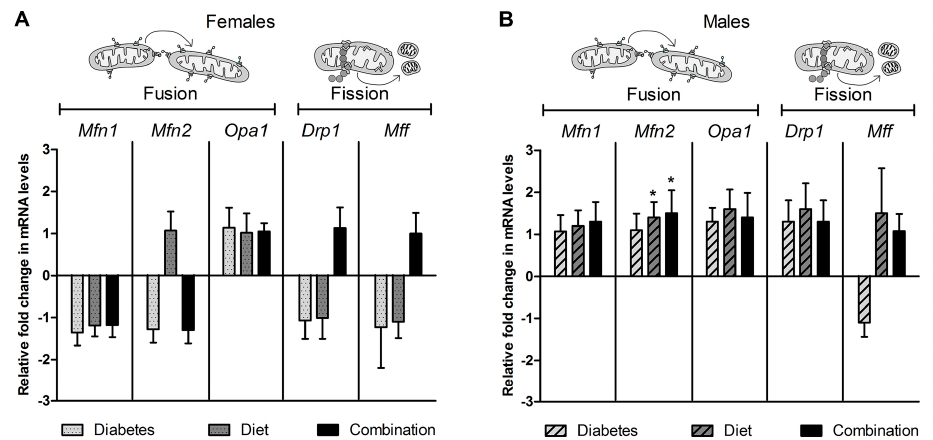
Figure 4. Cardiac expression of dynamism regulating genes cannot explain impaired dynamism in NRCM exposed to maternal diabetes, high-fat diet, or the combination of both. Whole heart mRNA was isolated from newborn offspring and relative expression of mitofusin 1 ( Mfn1 ), mitofusin 2 ( Mfn2 ), optic atrophy 1 ( Opa1 ), dynamin related protein 1 ( Drp1 ), and mitochondrial fission factor ( Mff ) was determined using qPCR; B2m was the reference gene. Bar graphs illustrate the average (mean ± SEM) fold change in expression compared to controls. Data are shown for ( A ) females ( n = 8/group) and ( B ) males ( n = 8 – 9/group), respectively. Significant ( p < 0.05) group differences are shown for * diet effect by two-way ANOVA. There was no statistically significant difference when males and females were pooled.